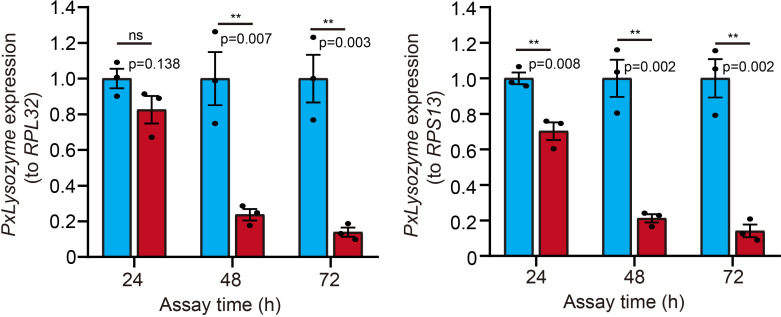
PxLysozyme expression was downregulated from 48 to 72 hr.Error bars represent the standard error of three independent biological replicates, with 30 P. xylostella larvae per replicate. Asterisks indicate significant differences (**p<0.01, ns, not significant; two-tailed unpaired t-test).
Figure 6—figure supplement 4—source data 1.PxLysozyme expression was downregulated from 48 to 72 hr.